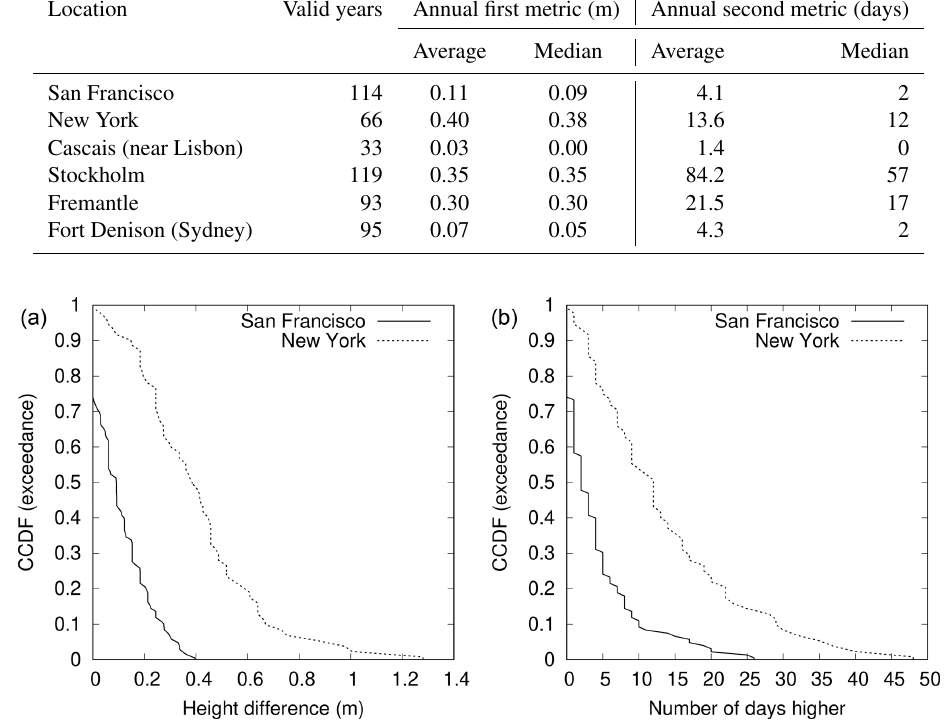
Figure 7. Complementary cumulative distribution functions (CCDFs) for San Francisco and New York. (a) Annual first metric , which is height of highest observed sea level above observed maximum on day of highest predicted tide for the year, for daylight days ( o d (I od (j,k),j,k) − o d (I pd (j,k),j,k) ), estimated over all valid years, j . (b) Annual second metric , which is no. of days when observed sea level, o d (i,j,k) , higher than observed maximum on day of highest predicted tide for the year, o d (I pd (j,k),j,k) , for daylight days , estimated over all valid years, j